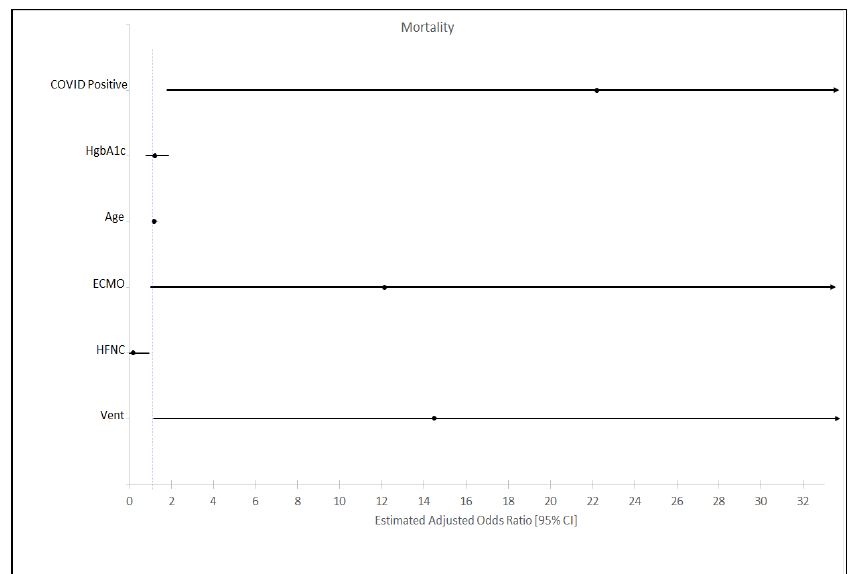
Figure 3. Kaplan – Meier curve comparing 28-day mortality of COVID-19 and non-COVID-19 ICU patients.